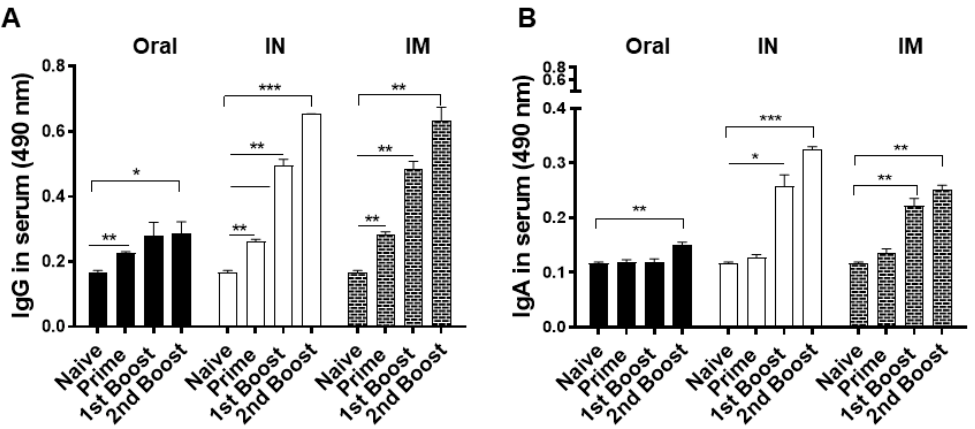
Figure 2. BALB/c mice were immunized with the vaccines as scheduled. Sera were collected from mice 3 weeks after each immunization and T. gondii -specific IgG ( A ) and IgA ( B ) antibody responses were measured by ELISA. Data are presented as mean ± SD and asterisks indicate statistical differences between groups. (* p < 0.1, ** p < 0.01, *** p < 0.001). All samples were acquired on an individual basis, and a total of three independent experiments were performed in triplicates.